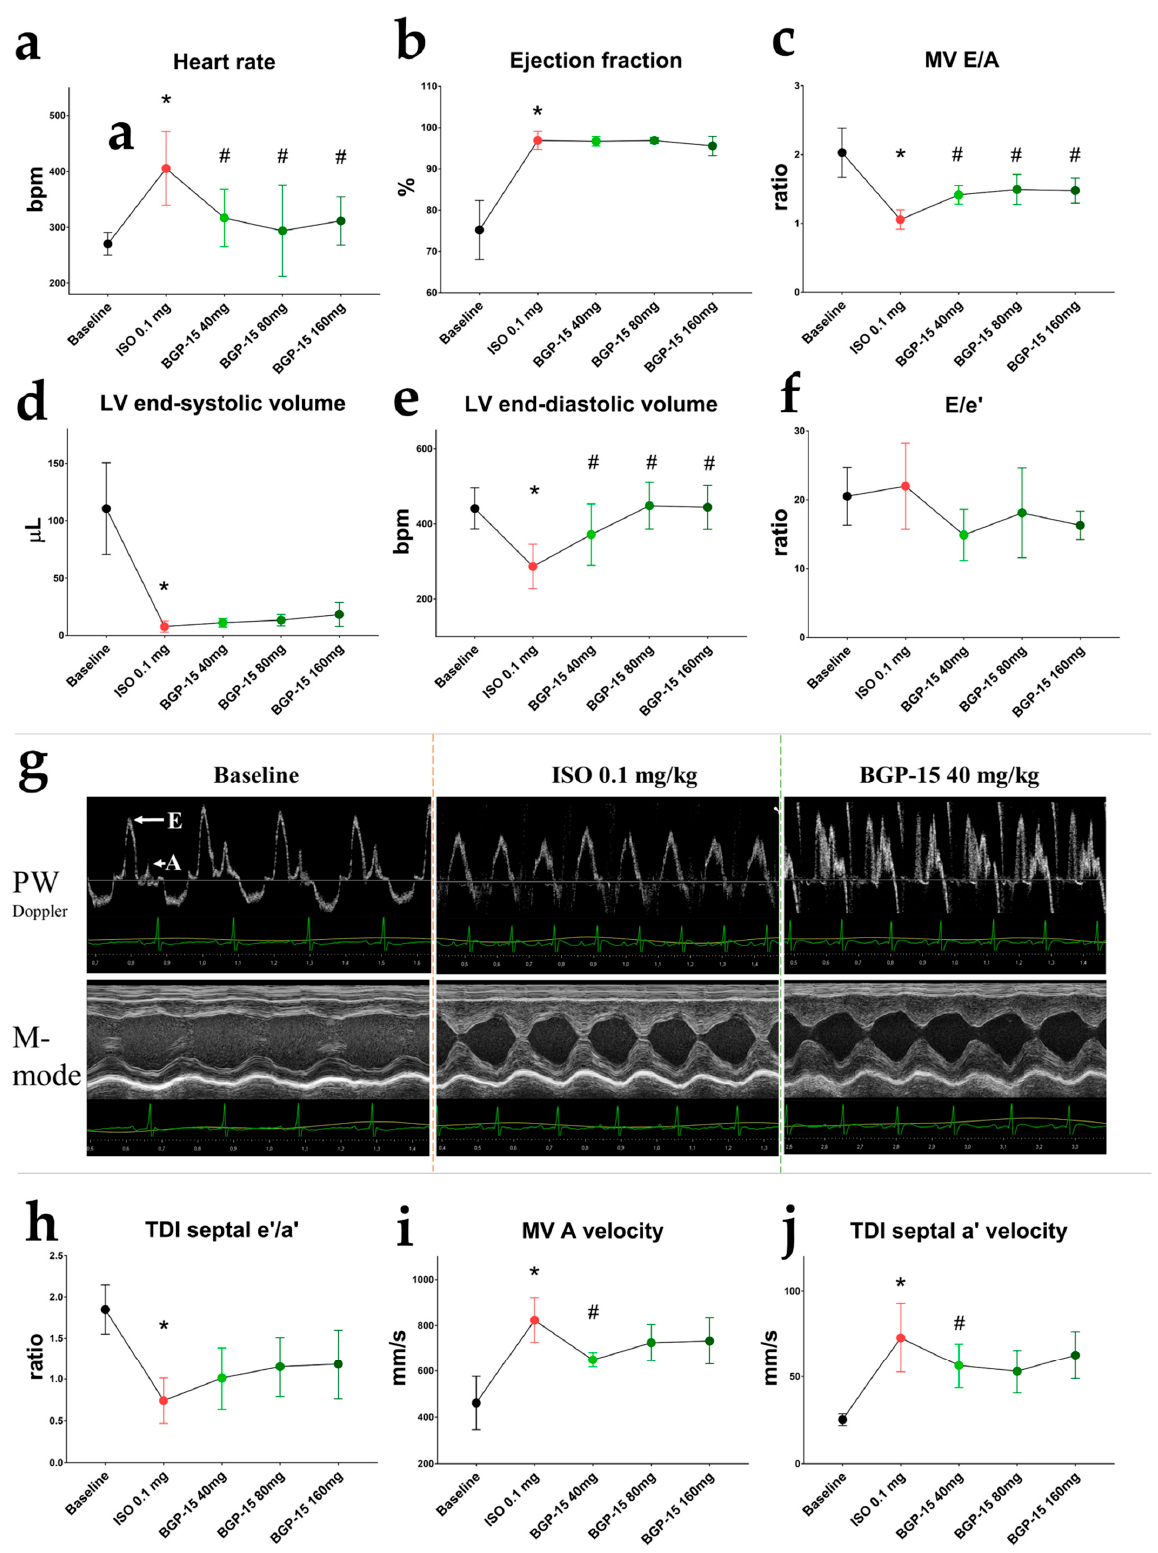
Figure 2. Effects of 40 mg/kg, 80 mg/kg, and 160 mg/kg cumulative doses of BGP-15 on echocardio- graphic parameters of ISO-treated rats. ( a ) HR increased after ISO administration but decreased